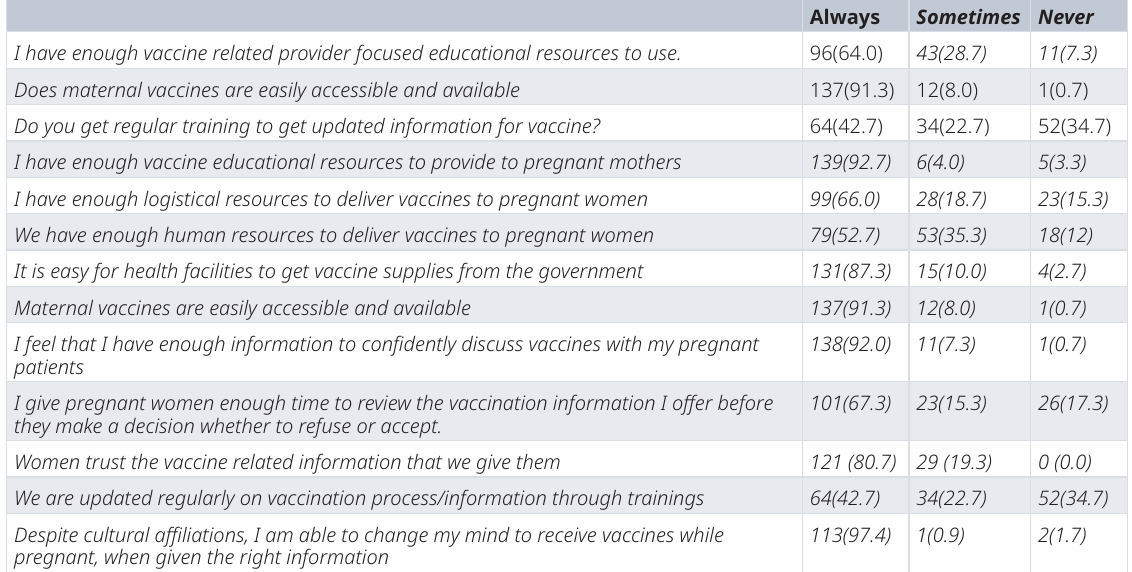
Table 4. Antenatal care (ANC) providers beliefs about availability of